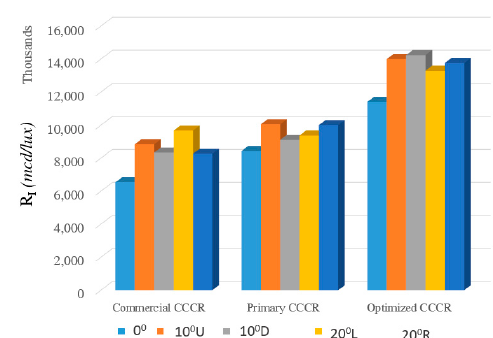
Figure 19. Comparison of the reflection efficiency R A of commercial CCCR, primary CCCR and optimized CCCR.